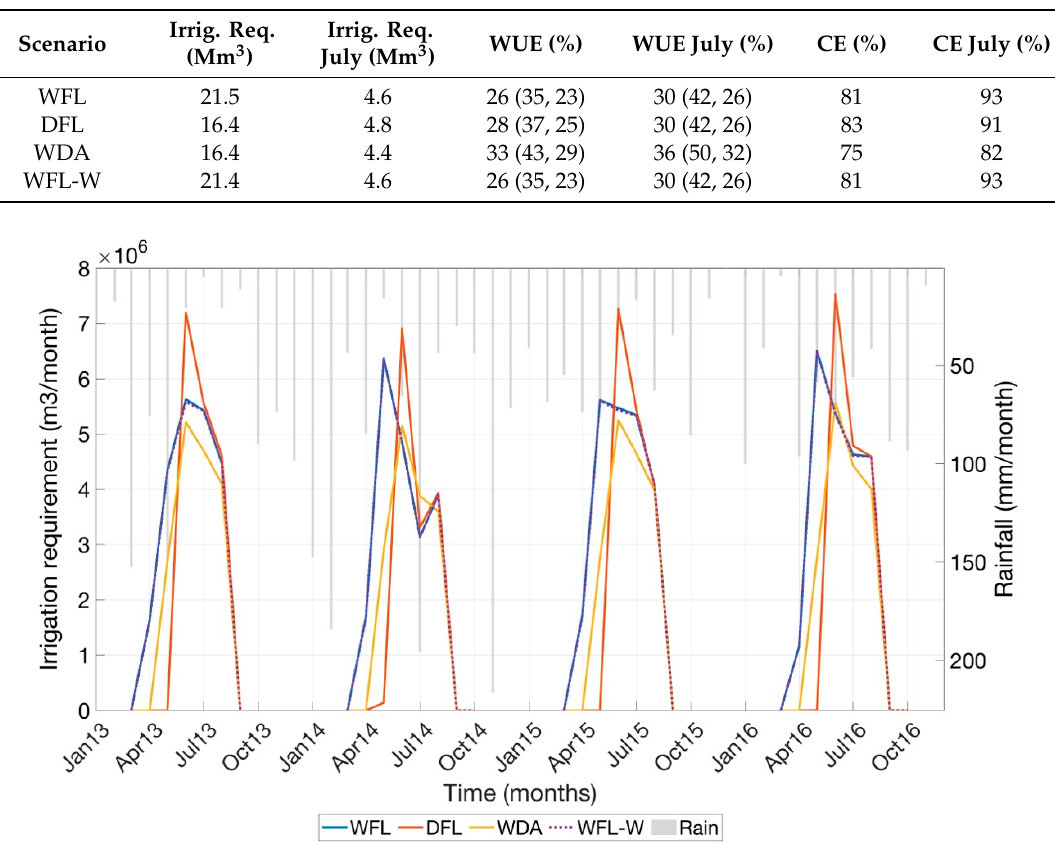
Table 5. Results of the four scenario simulations (WFL, wet seeding and continuous flooding; DFL, dry seeding and delayed flooding; WDA, dry seeding and alternate wetting and drying; WFL-W, wet seeding and continuous flooding followed by winter flooding) in terms of district total irrigation requirement (Irrig. Req.), WUE of the agricultural area, and channel e ffi ciency (CE); values reported are averaged over four meteorological years (2013–2016). Values in brackets are referred to shallow and deep GW zones, respectively.